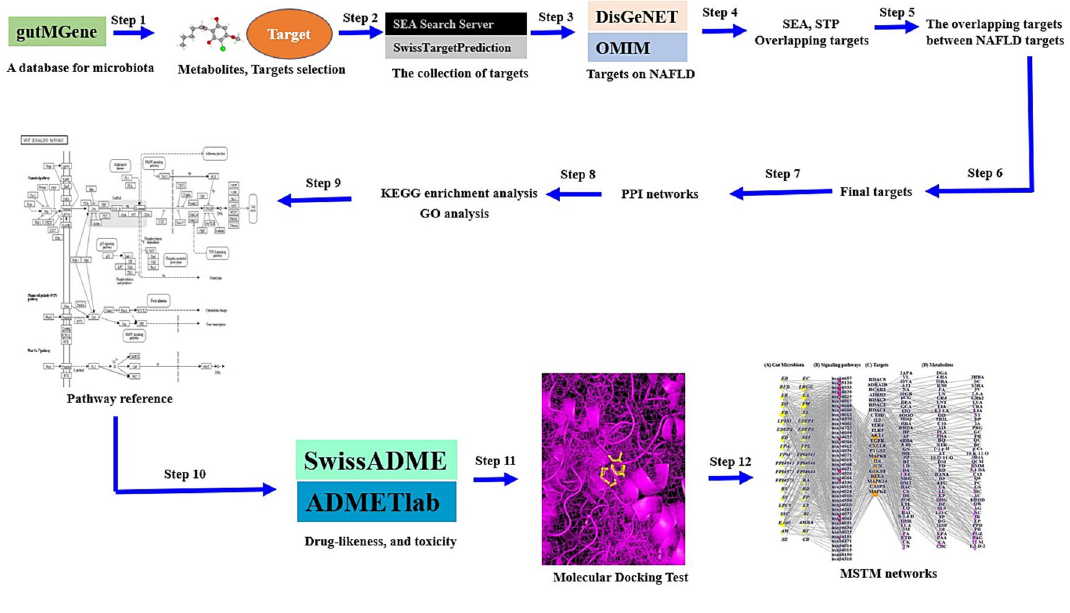
Figure 1. The workflow of this